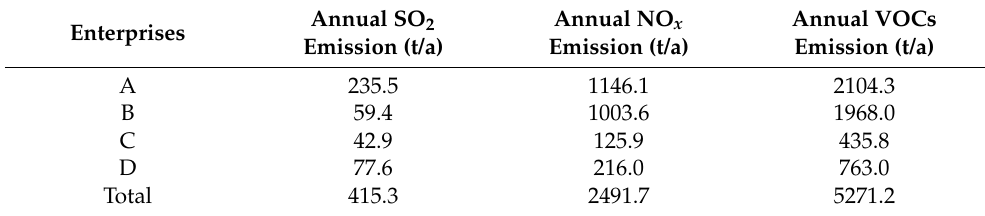
Table 1. SO 2 and NO x emissions from four typical petrochemical enterprises in